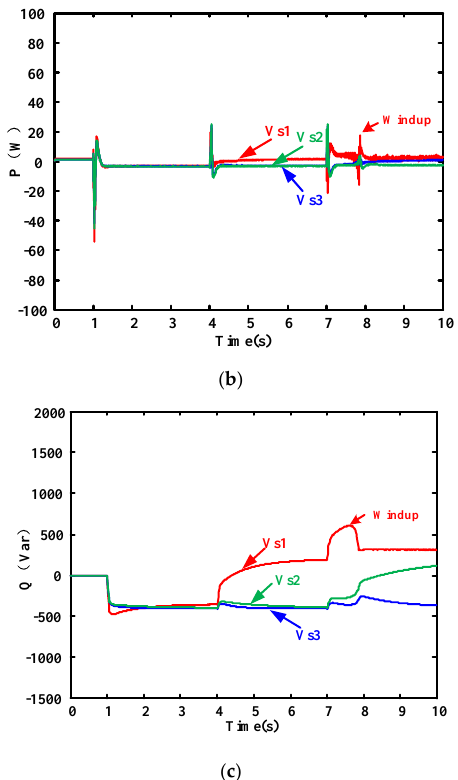
Figure 11. Simulation results of multiple ESs operating without coordinated control: ( a ) RMS value of point of common coupling (PCC) voltage; ( b ) active power; ( c ) reactive power.